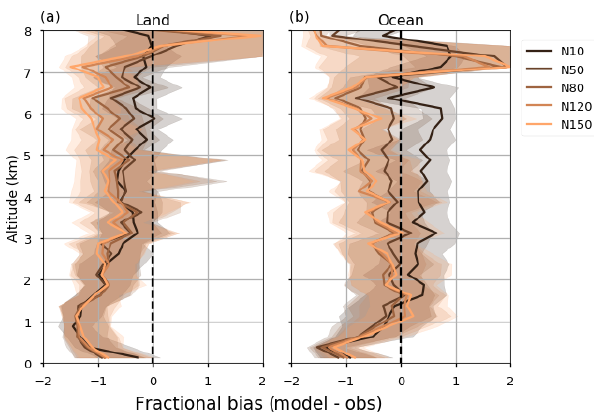
Figure 5. The vertical profile of fractional bias in modelled aerosol number at different size cut-offs for land (a) and ocean (b) measure- ments.